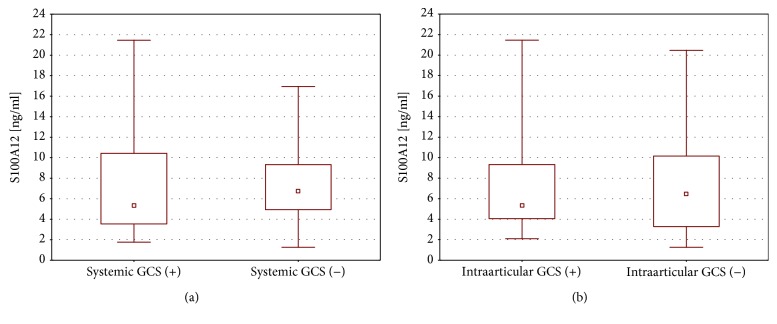
S100A12 levels at 2nd time point depending on (a) systemic GCS intake within the observation period and (b) intraarticular GCS injection at 1st time point. GCS: glucocorticosteroids.